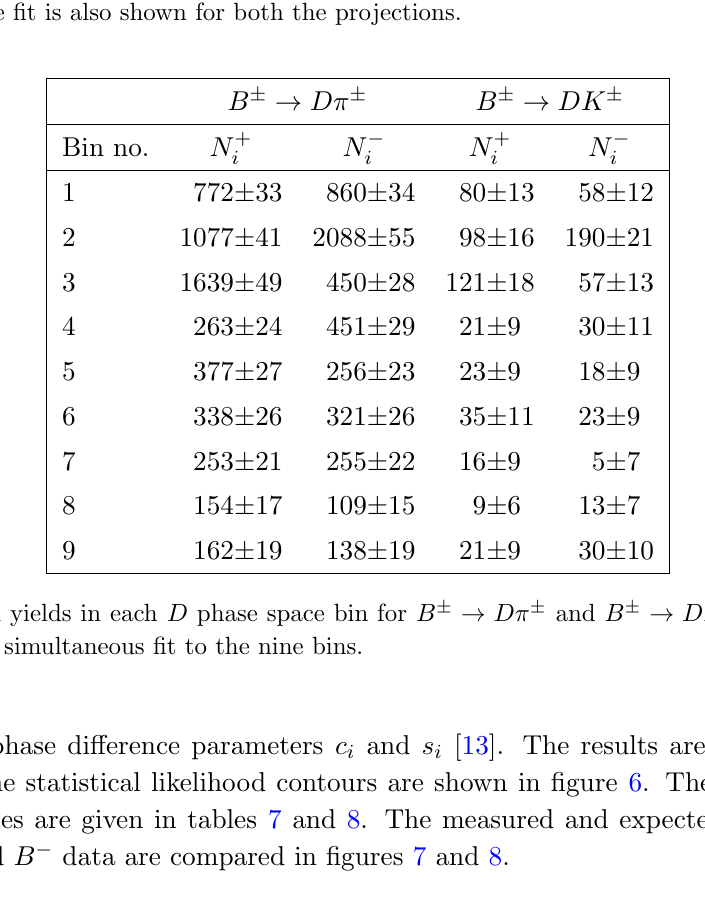
table 6, and the statistical likelihood contours are shown in (cid:12)gure 6. The statistical cor- relation matrices are given in tables 7 and 8. The measured and expected yields for the binned B + and B (cid:0) data are compared in (cid:12)gures 7 and